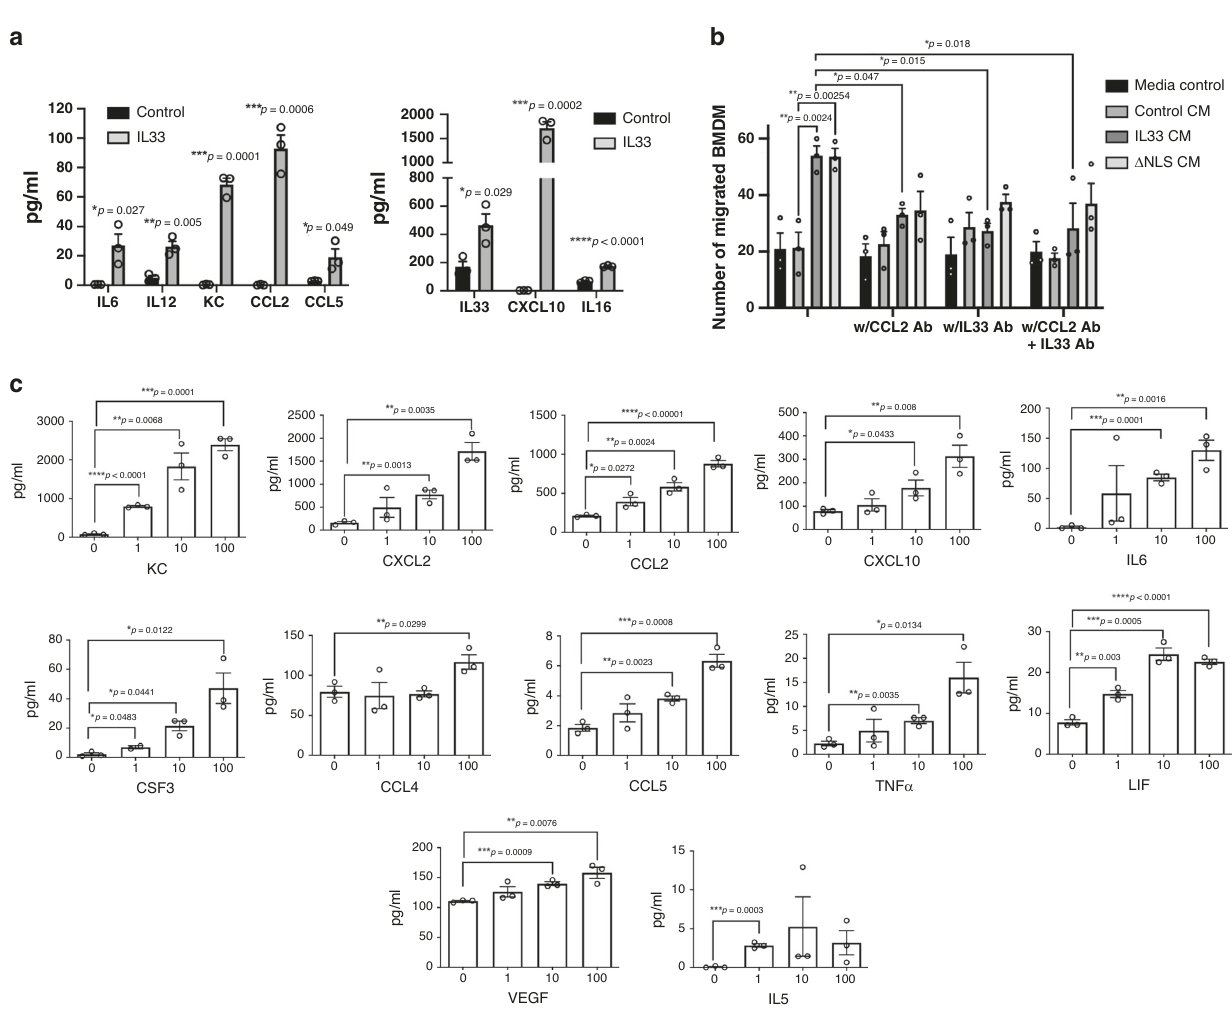
Fig. 7 A functional role for an IL-33-orchestrated tumor microenvironment. a Cytokine levels in the tumor interstitial fl uid (TIF) from IL-33 − (control) or IL-33 + (IL-33) K1492 cells. N = 3 independent experiments expressed as the mean ± SEM; * p ≤ 0.05, ** p ≤ 0.01, *** p ≤ 0.001, **** p ≤ 0.0001 by two- tailed unpaired Student ’ s t -test. b Macrophage were harvested from the femur of mice, differentiated for 7 days and plated in transwells with conditioned medium (CM) from control, IL-33, or Δ NLS-expressing U87 in the presence or absence of CCL2, and/or IL-33 neutralizing antibodies. Graph shows the number of BMDM that migrate in 4 h. Data are mean of three replicates ± SEM. N = 3 experiments with comparable results; * p ≤ 0.05, ** p ≤ 0.01 by one- way ANOVA Dunnett ’ s post hoc test. c BMDM were treated with rIL-33 (0 – 100 pg/ml) and cytokine levels in the CM were measured by Luminex. Results from three independent experiments are expressed as the mean ± SEM; * p ≤ 0.05, ** p ≤ 0.01, *** p ≤ 0.001, **** p ≤ 0.0001 compared to no treatment by one-way ANOVA with Tukey ’ s post hoc test. See also Supplementary Fig. 6. Source data are available as a Source data fi